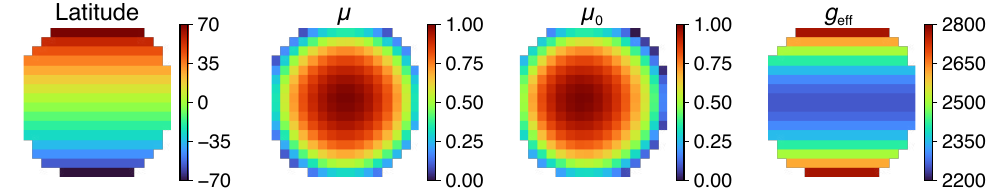
Figure 10. Geometrical parameter values for radiative transfer calculations. We created a 16 × 16 grid by coarsely sampling the geometry for actual HST images taken during PJ 42, matching the relevant sub-observer and sub-solar latitudes. The geometric sampling was designed to test the relative effects of emission angle cosine ( µ ), incidence angle cosine ( µ 0 ), and effective gravity ( g eff ), which varies with latitude and affects the atmospheric gas pressure scale height H g = RT / µ g eff